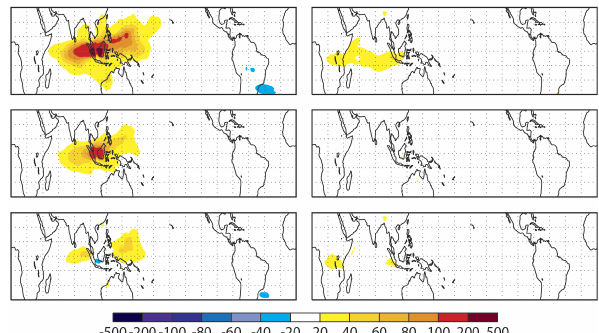
Figure 17. TCCO differences in percent for October (left) and December (right) from the experiments BASE06–BASE05 (top), BASE06–CLIM06 (middle) and CLIM06–CLIM05 (bottom). Red colours indicate positive values and blue colours negative